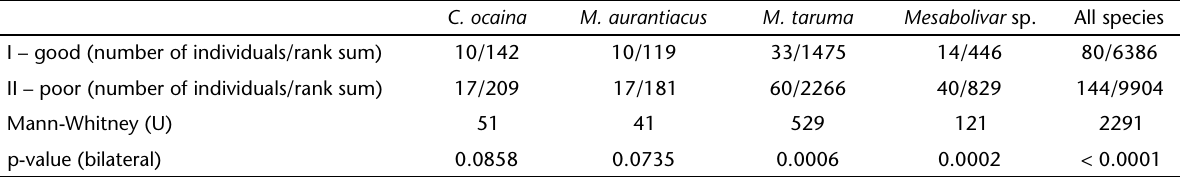
Table III. Mann-Whitney test results to verify abundance by forest gap regeneration type for C. ocaina , M. aurantiacus , M. taruma , Mesabolivar sp. and the combined data for all Pholcidae species collected at Porto Urucu, Coari,